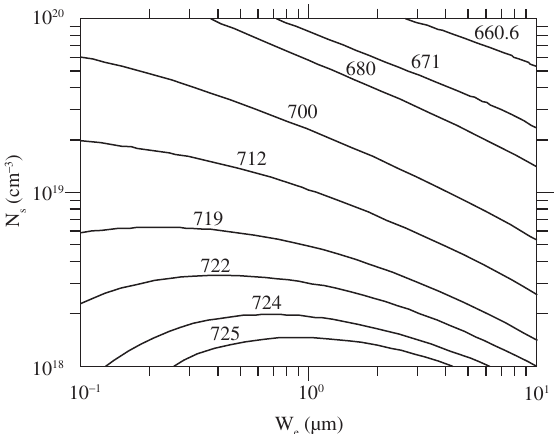
Figure 10. Open-circuit voltage contour plots, V surface doping concentration, N cell with base resistivity 1 Ω